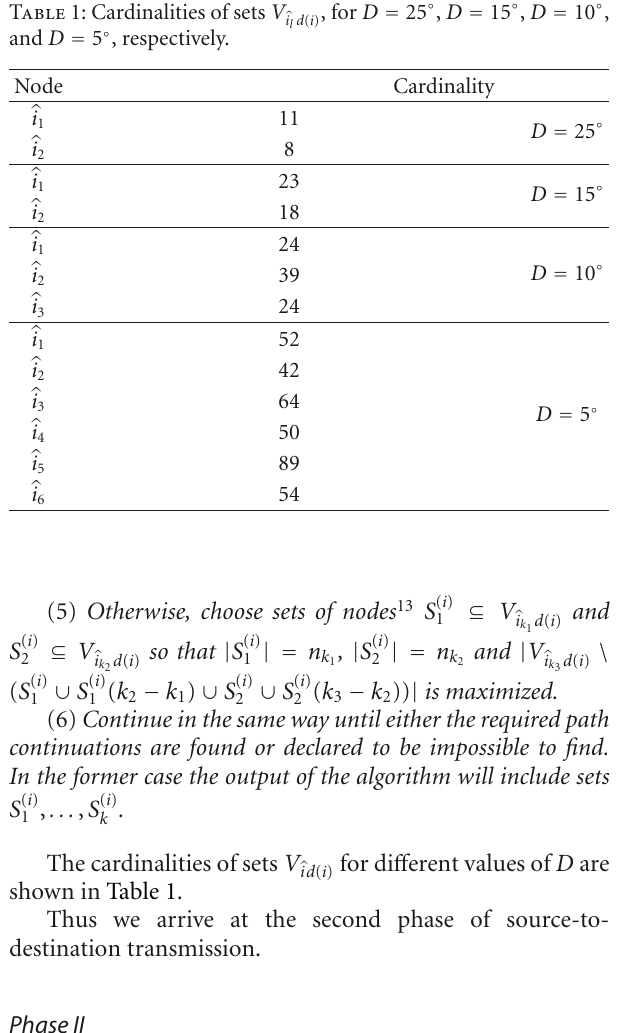
, for D = 25 ◦ , D = 15 ◦ , D = 10 ◦ , i l d ( i )